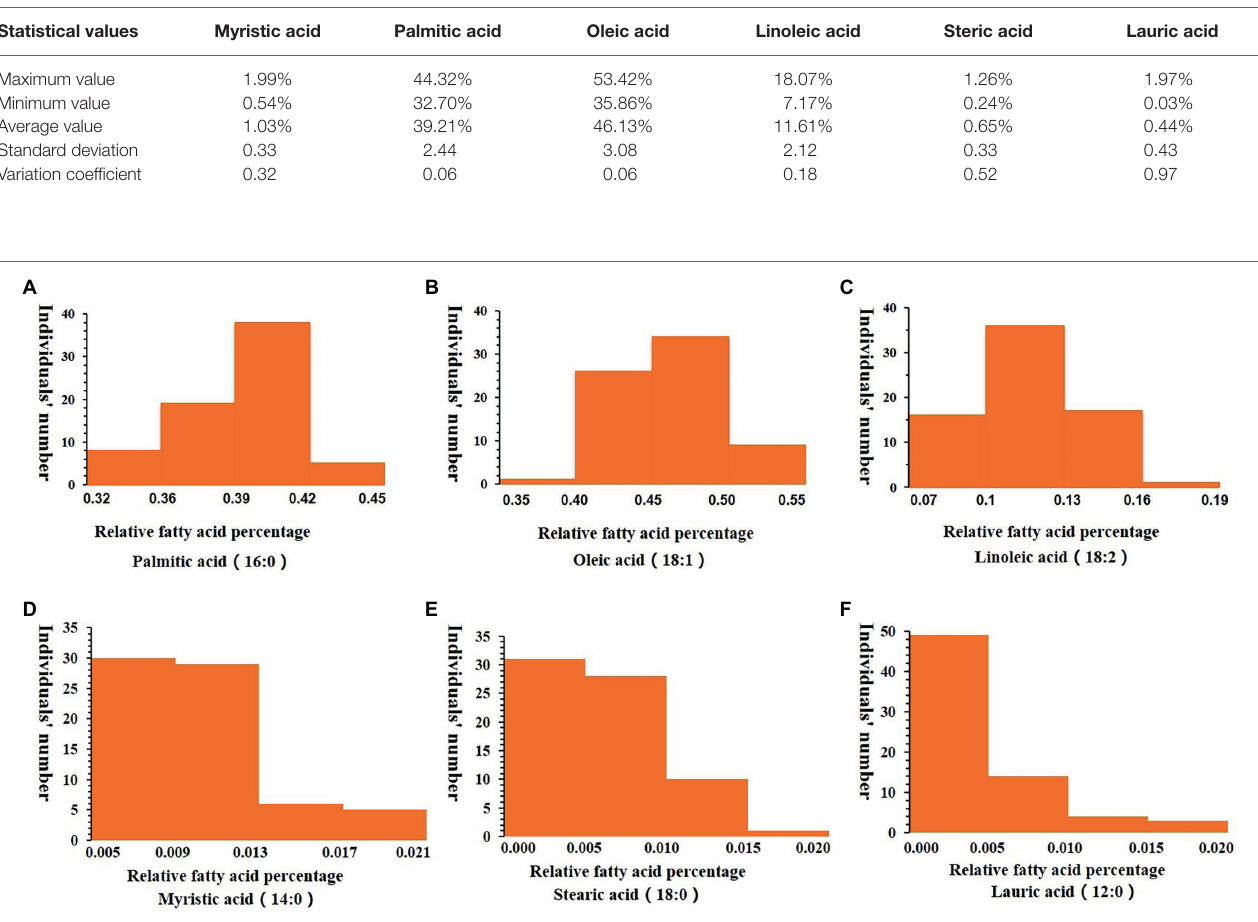
FIGURE 4 | Frequency distribution of relative fatty acid percentages in the mesocarp of 70 oil palm individuals, including palmitic acid (16:0; A ), oleic acid (18:1; B ), linoleic acid (18:2; C ), Myristic acid (14:0; D ), Stearic acid (18:0; E ) and Lauric acid (12:0; F ). The x-axis represents the trait value, and the y-axis represents the number of oil palm individuals.